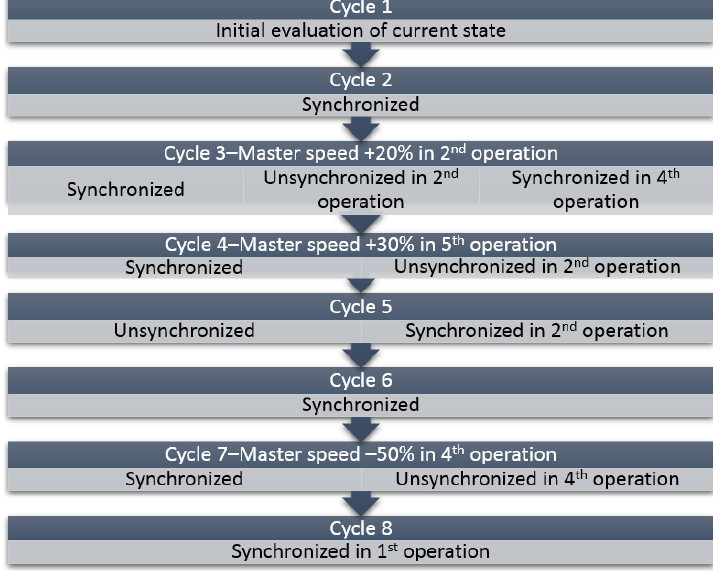
Figure 11. Percentage proportion deviation with feedforward synchronization — Experiment 1b. Appl. Sci. 2020 , 10 , x FOR PEER REVIEW